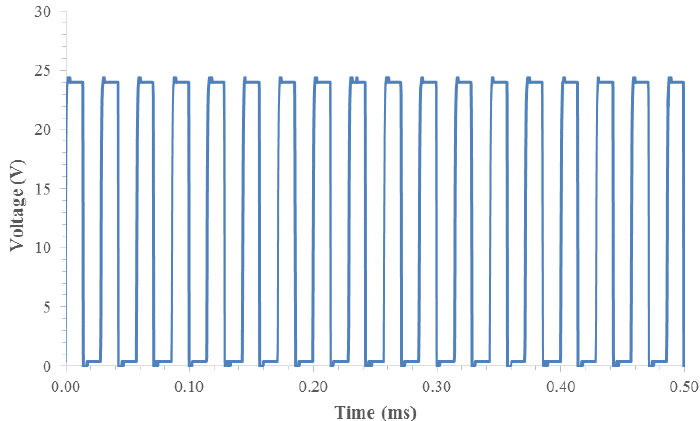
Figure 5. Sample pulse train from FPGA to input of servo amplifier.